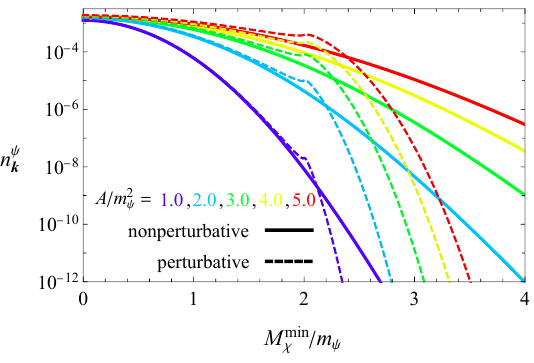
Figure 2 . The number of daughter particles produced n ψ A with various values of the minimum of the parent particle mass M min The thick and dashed lines show the non-perturbative result in the slow-field limit (2.38) and the phenomenological perturbative result (2.41), respectively. The other parameters are fixed as a ( t prod ) = 1 and λ = 1 .